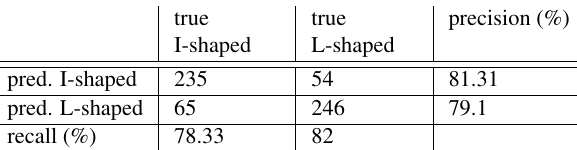
Table 4. Classification results of room shapes. Two classes (I and L) are considered.